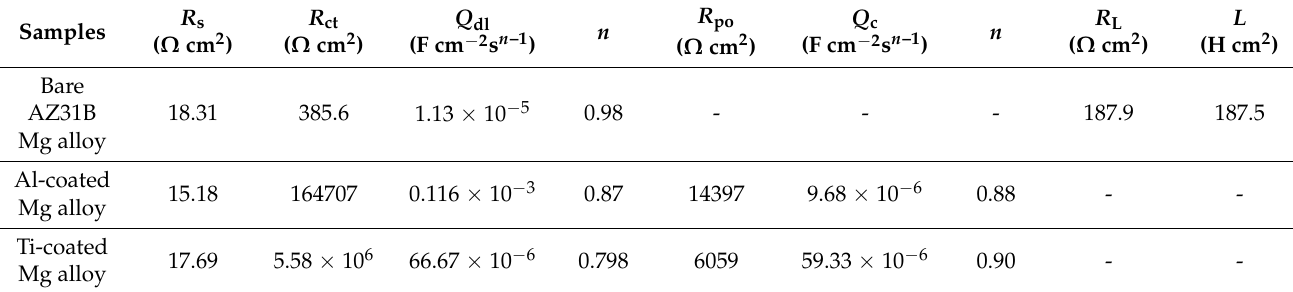
Table 4. EIS fitted results for bare and coated samples in 3.5 wt % NaCl